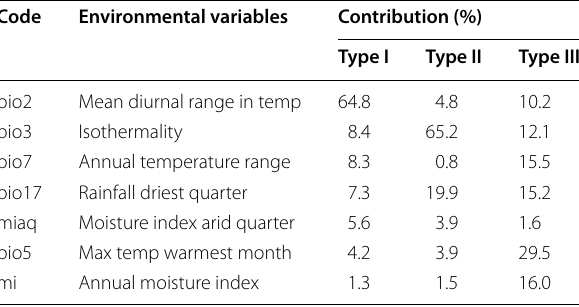
Table 6 Environmental variables less correlated and their contribution to the